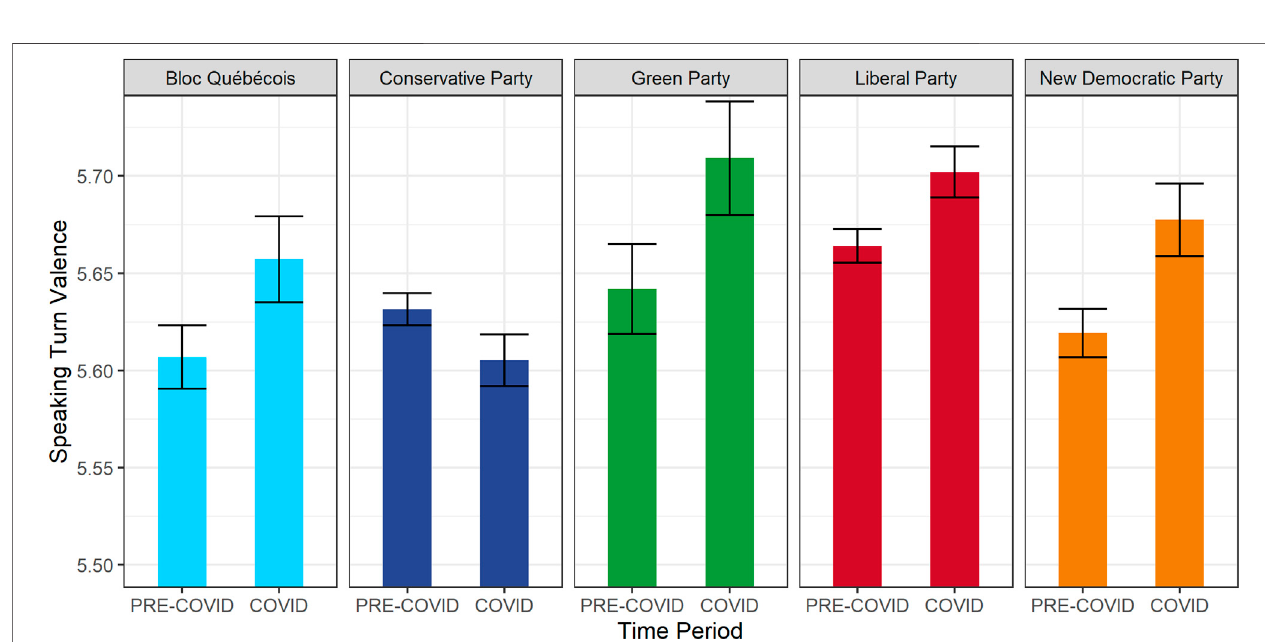
FIGURE3 | Speaking turn valence forall represented Canadian political parties before and after the onset oftheCOVID-19 pandemic,based onthe estimates ofa linear mixed-effects regression model (see Supplementary Table S3 for a summary).